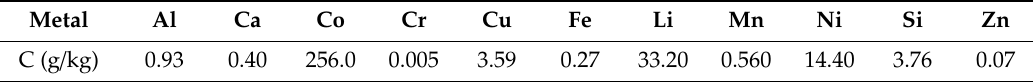
Table 2. Metal content in the sample of powder from the spent Li-ion batteries [32].